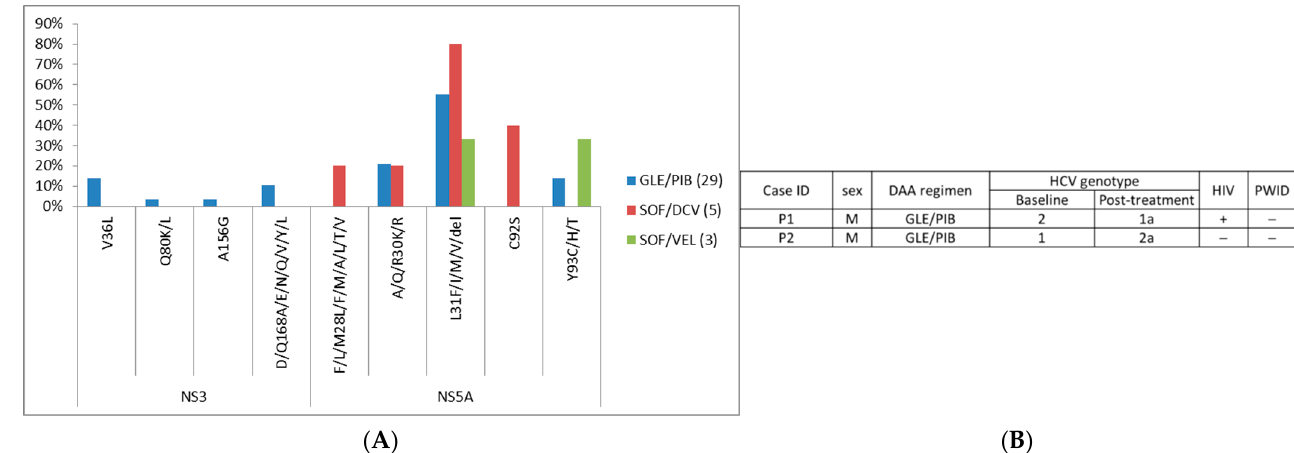
Figure 3. Summary of ( A ) RASs in patients with pan-genotype DAA treatment and ( B ) cases with different baseline/post- treatment HCV genotype. “+”, positive; “ − ”, negative.